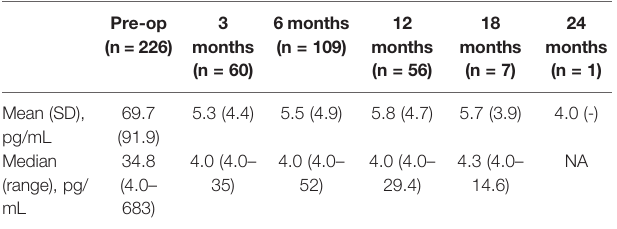
TABLE 1 | Patient and tumor characteristics.